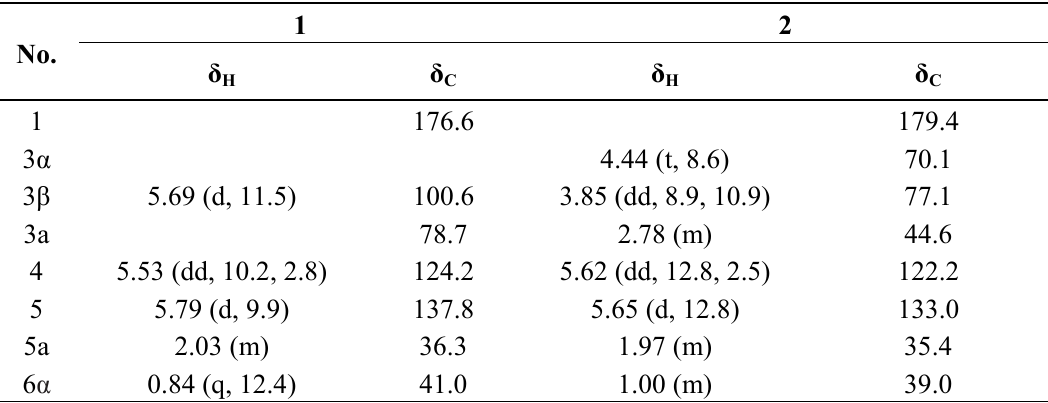
Table 1. 1 H- and 13 C-NMR spectroscopic data of compounds 1 and 2 ( 1 and 2 at 600 MHz, CDCl , chemical shift values are in ppm relative to TMS; multiplicity and J values (in Hz) 3 are presented in